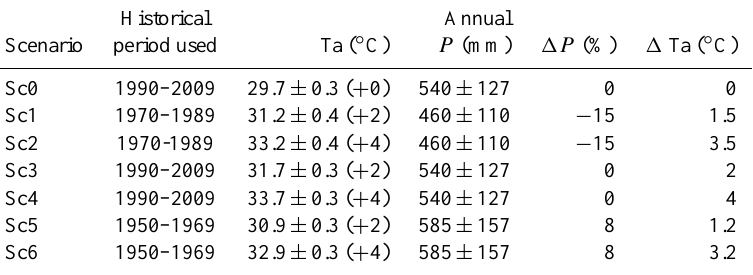
Table 1. Mean precipitation ( P ) and temperature (Ta) for the reference climate scenario (Sc0, 1990–2009) and six future climate scenarios (Sc1 to Sc6). Displayed are the mean ± one standard deviation for Ta and P , as well as its increase compared to the historical period used for Ta (in parenthesis). Scenario names Sc1 to Sc6 are ordered from low to high P and Ta. (cid:49)P and (cid:49) Ta refer to differences relative to Sc0.